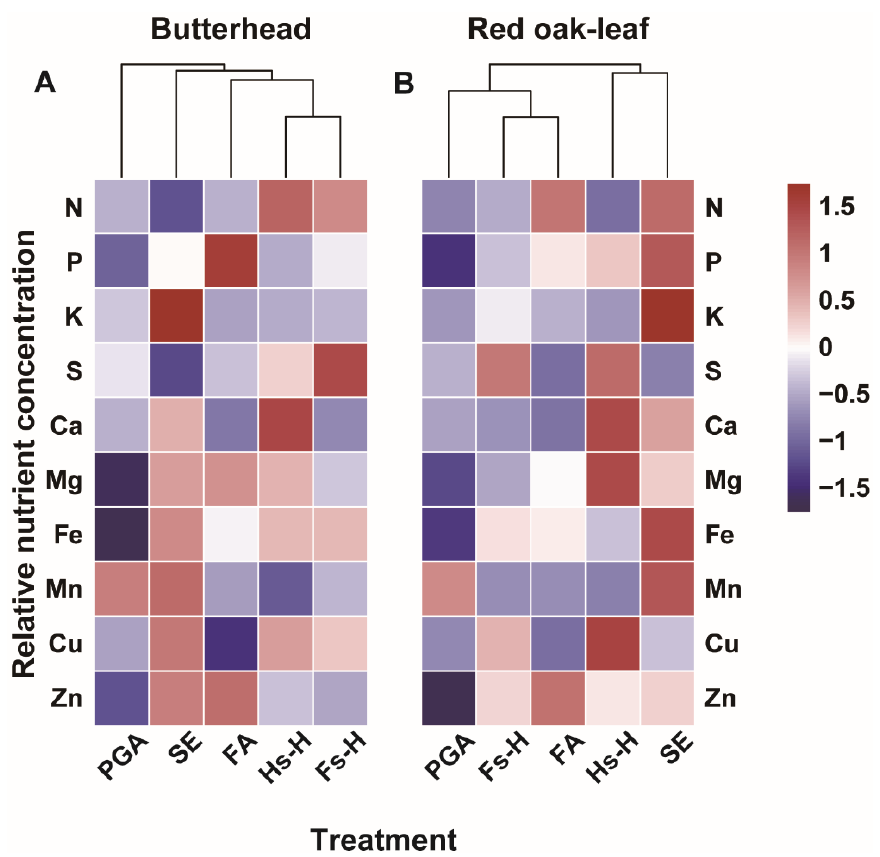
Figure 3. Macro and micronutrient concentration in the shoots of ( A ) butterhead and ( B ) red oak-leaf under different nutrient solution treatments. Nutrient concentration was normalized by the z−score; the red and blue colors indicate upregulation and downregulation, respectively.